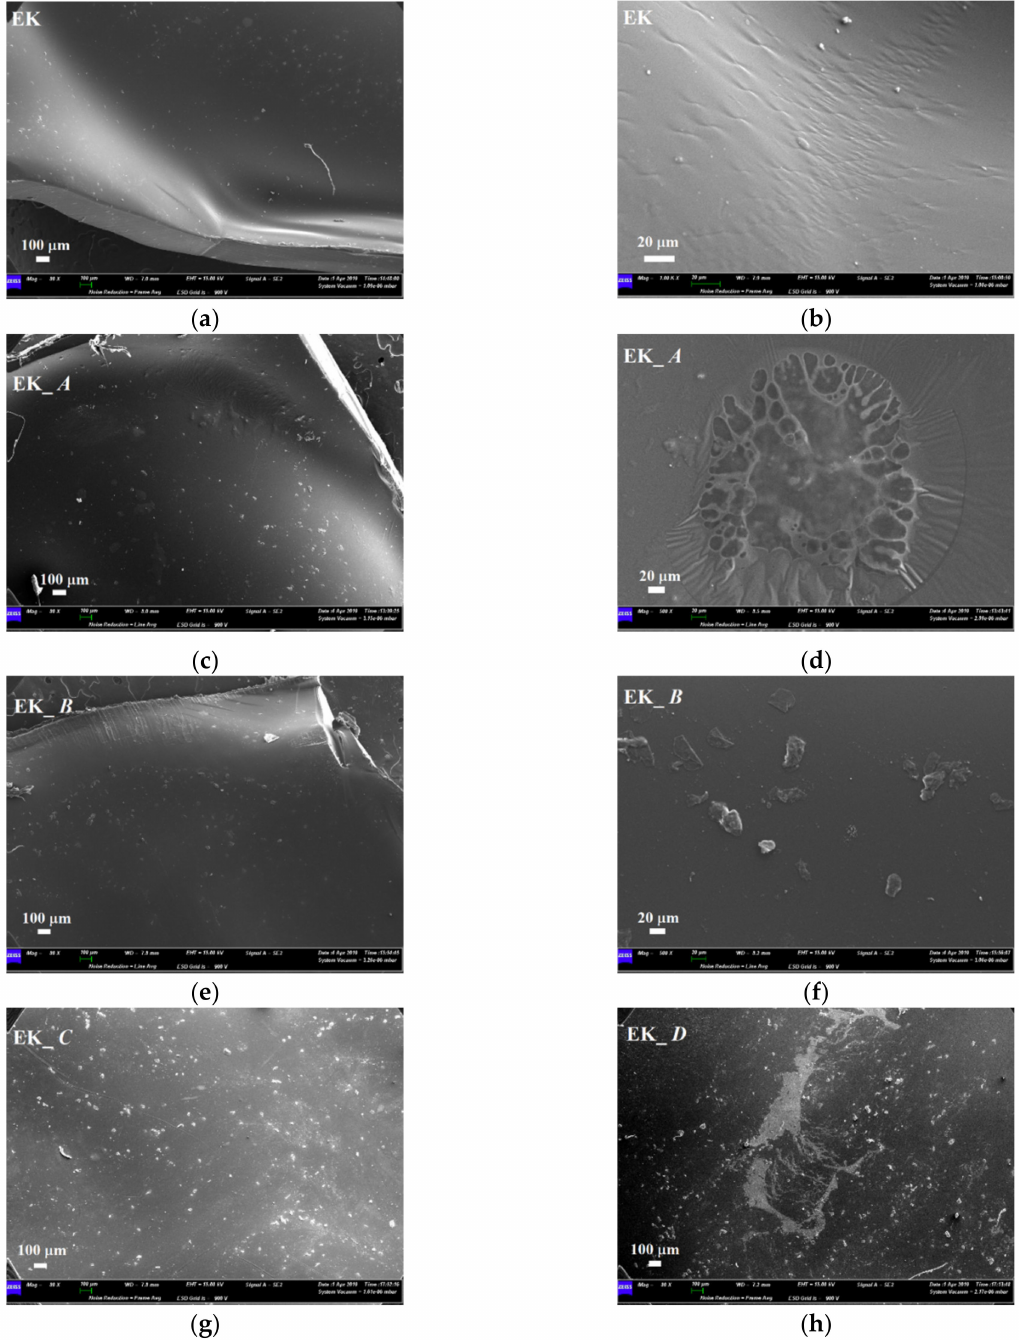
Figure 9. Comparison between SEM micrographs of Erkodur (EK) aligner before and after 2 weeks of immersion into staining beverages; ( a , b ) as-received sample; ( c , d ) sample immersed into artificial saliva (A); ( e , f ) sample immersed into nicotine (B); ( g ) sample immersed into red wine (C); ( h ) sample immersed into coffee